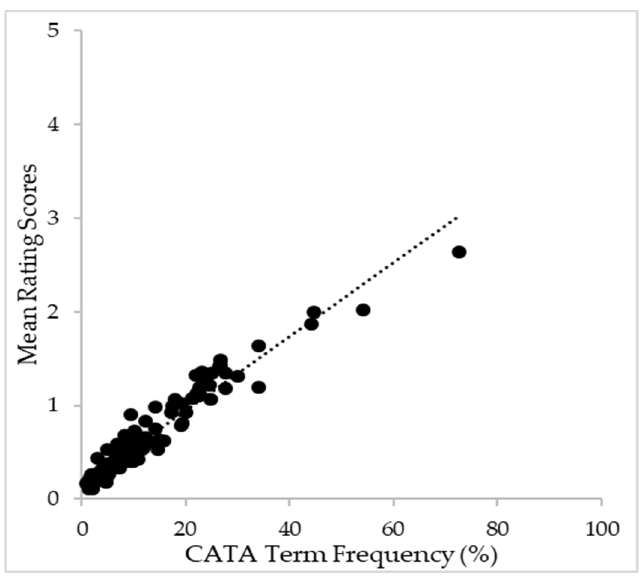
Figure 3. Plot of relation between CATA citation frequency (0–100%) according to mean rating score (0–5 point scale) using all sensory terms provided to consumers.